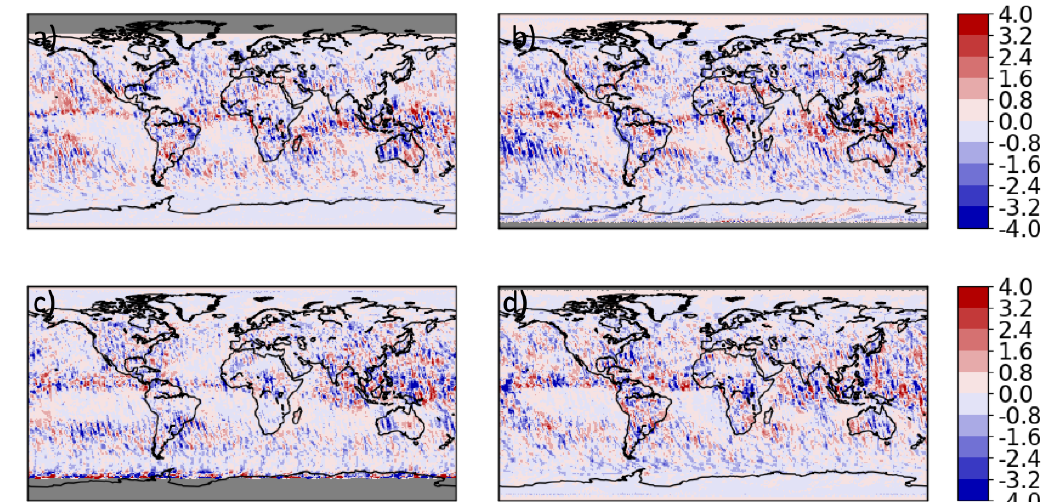
Figure 8. Monthly mean daytime LW flux difference between using all footprints and only using footprints with viewing zenith angles less than 66 ◦ for January ( a ), April ( b ), July ( c ), and October ( d ) 2014 from CERES NPP observation. Regions in grey only have nighttime observations.